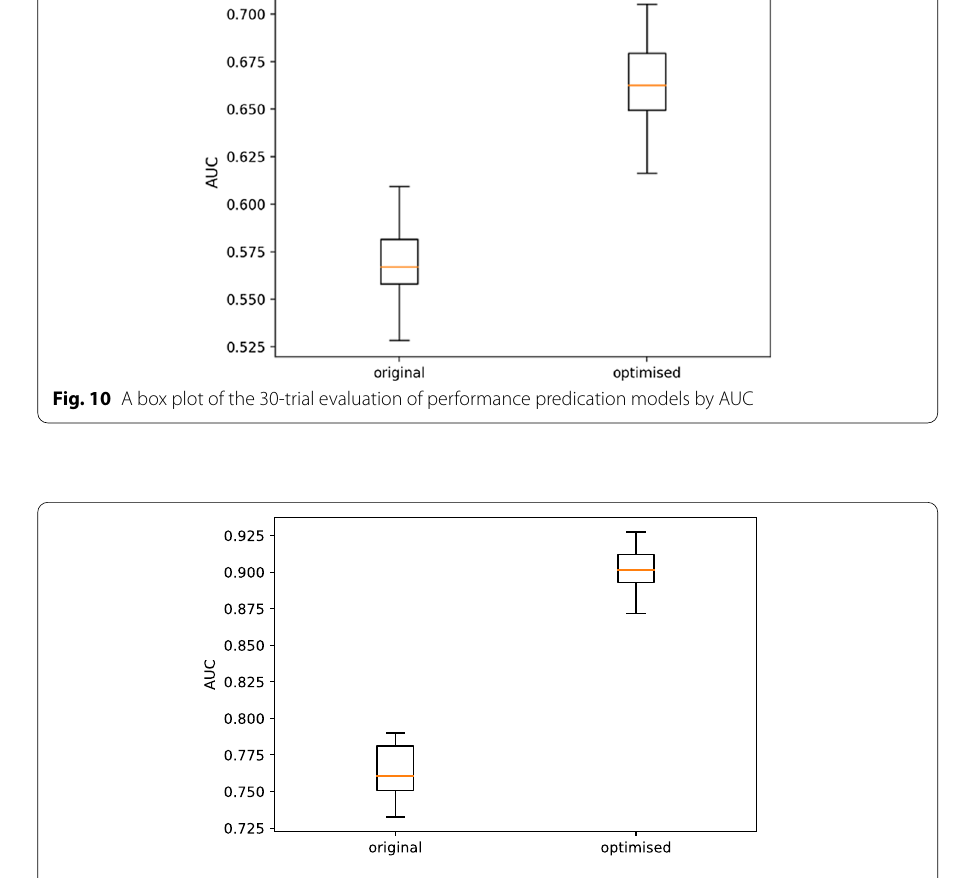
Fig. 11 A box plot of the 30-trial evaluation of engagement predication models by